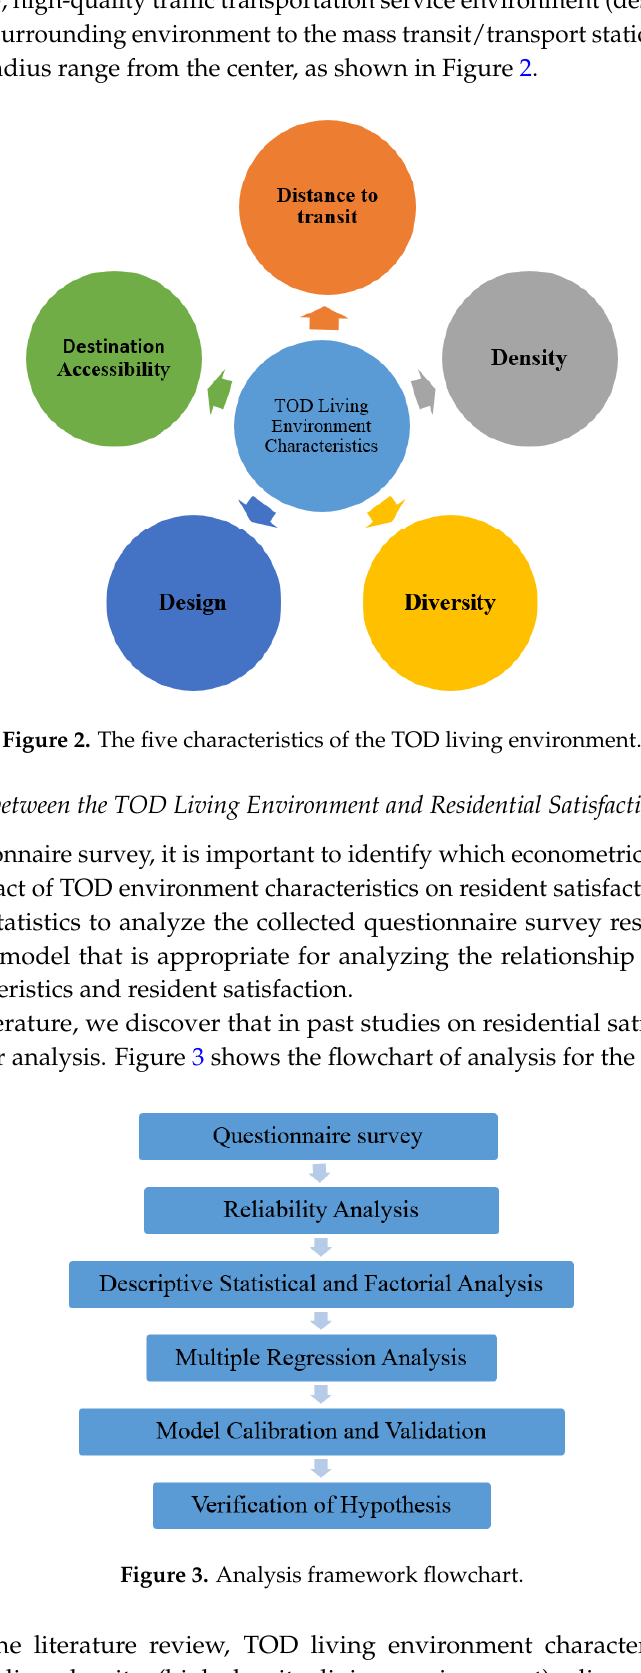
Figure 3. Analysis framework flowchart.